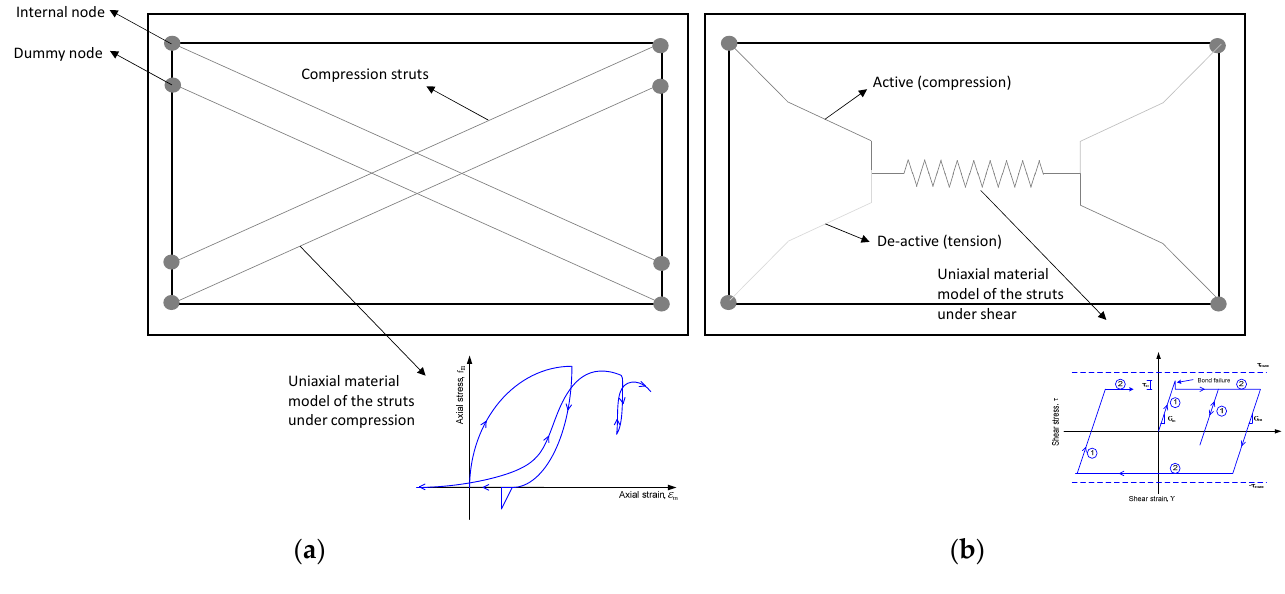
Figure 1. Modeling strategy adopted for the masonry infill walls: ( a ) under compression; and ( b ) under shear.